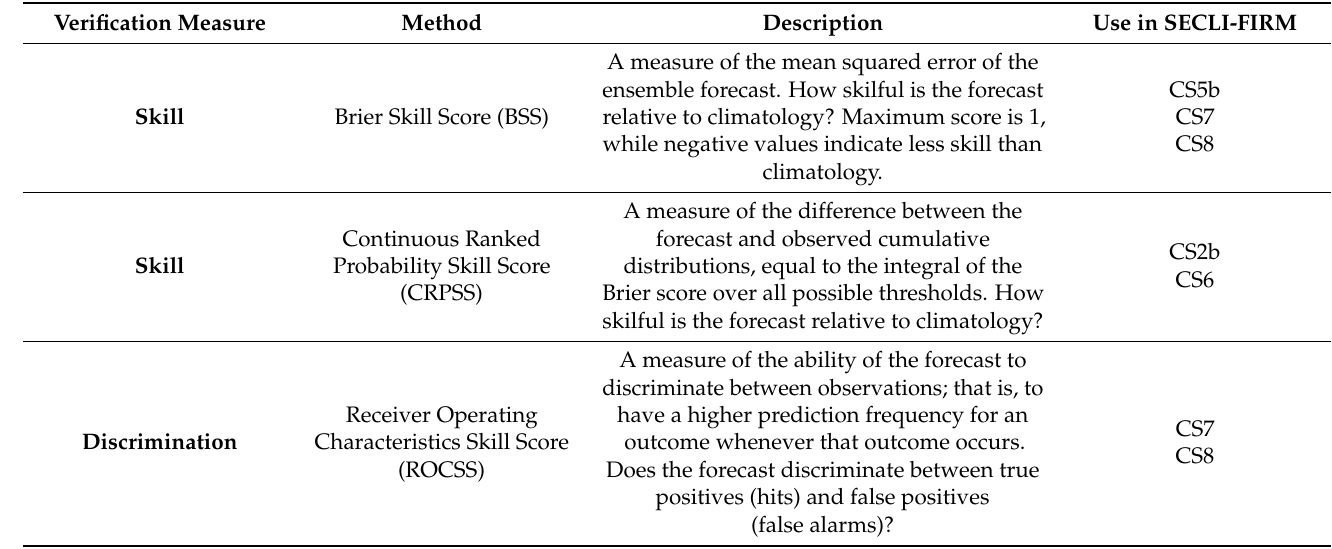
Table 3. Metrics used to verify performance of probabilistic seasonal forecasts in SECLI-FIRM case